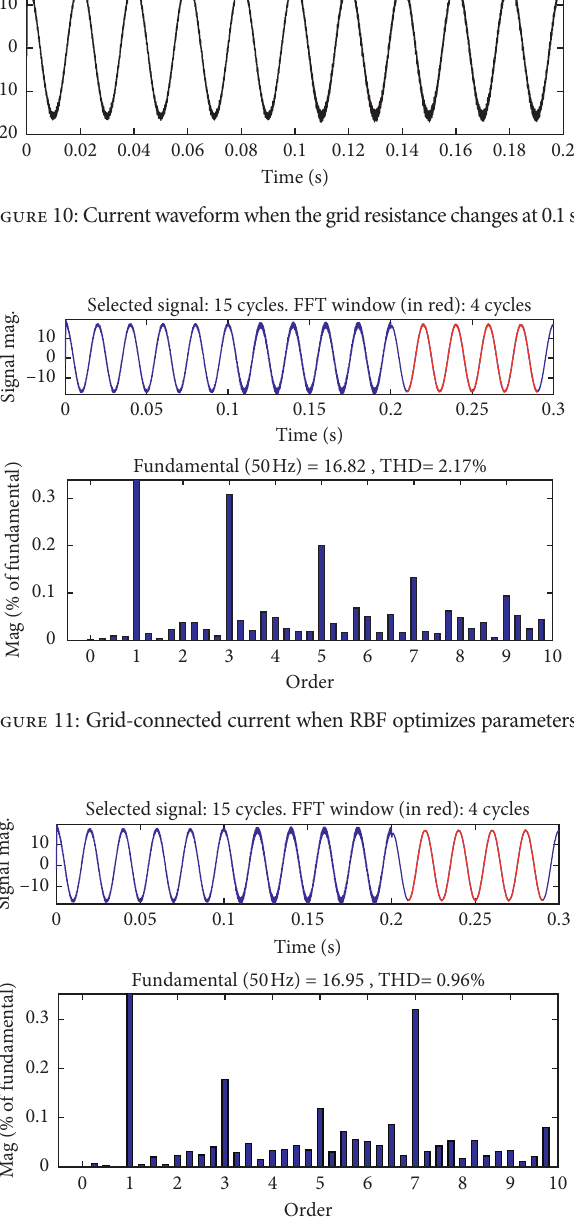
Figure 12: Grid-connected current under PSO_RBF optimization